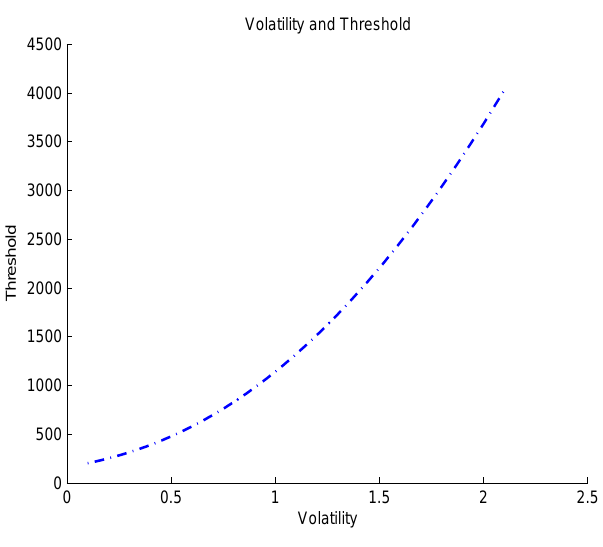
Figure 4. Uncertainty and optimal investment